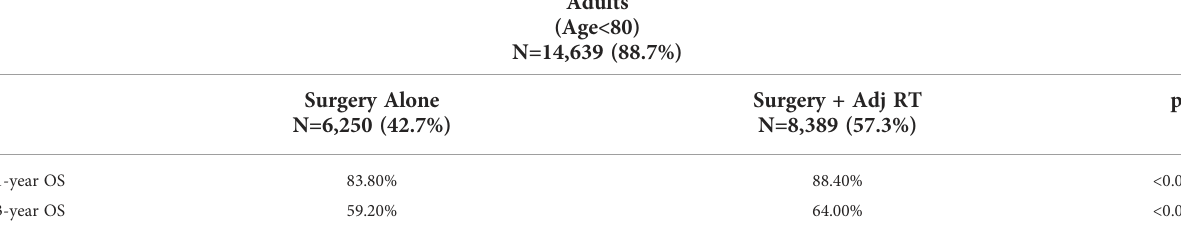
Adults (Age<80) N=14,639